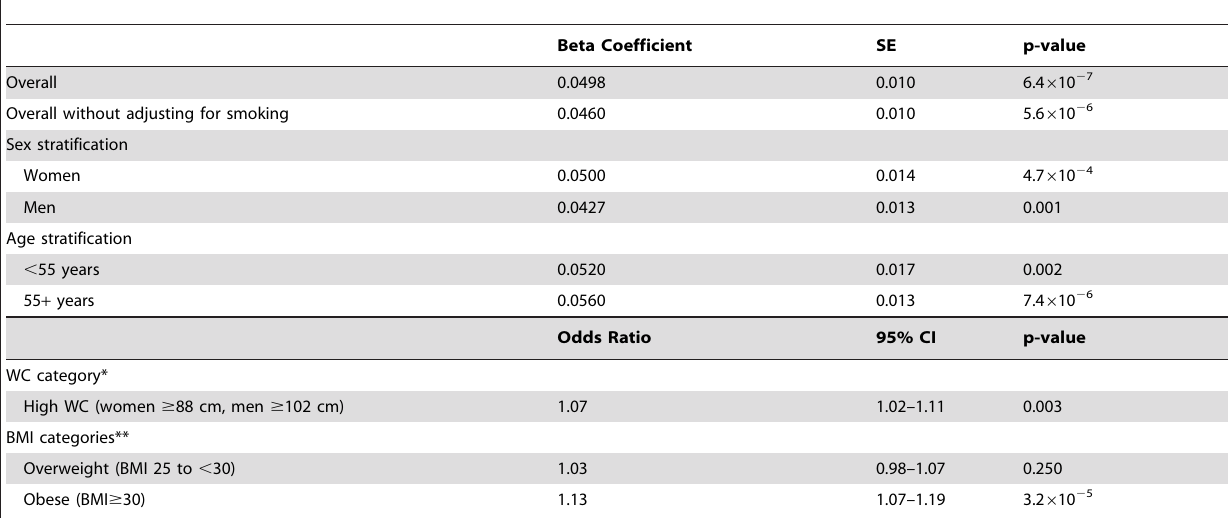
Table 4. CHARGE consortium secondary analysis results per copy of the G allele for rs10146997 in 31373 individuals; beta coefficients expressed as z-scores.